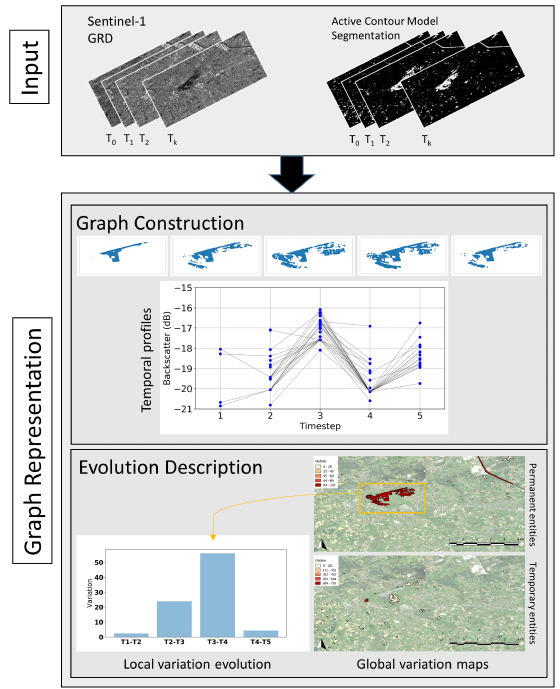
Figure 3. Framework for object-based graph representation adapted from Khiali et al.